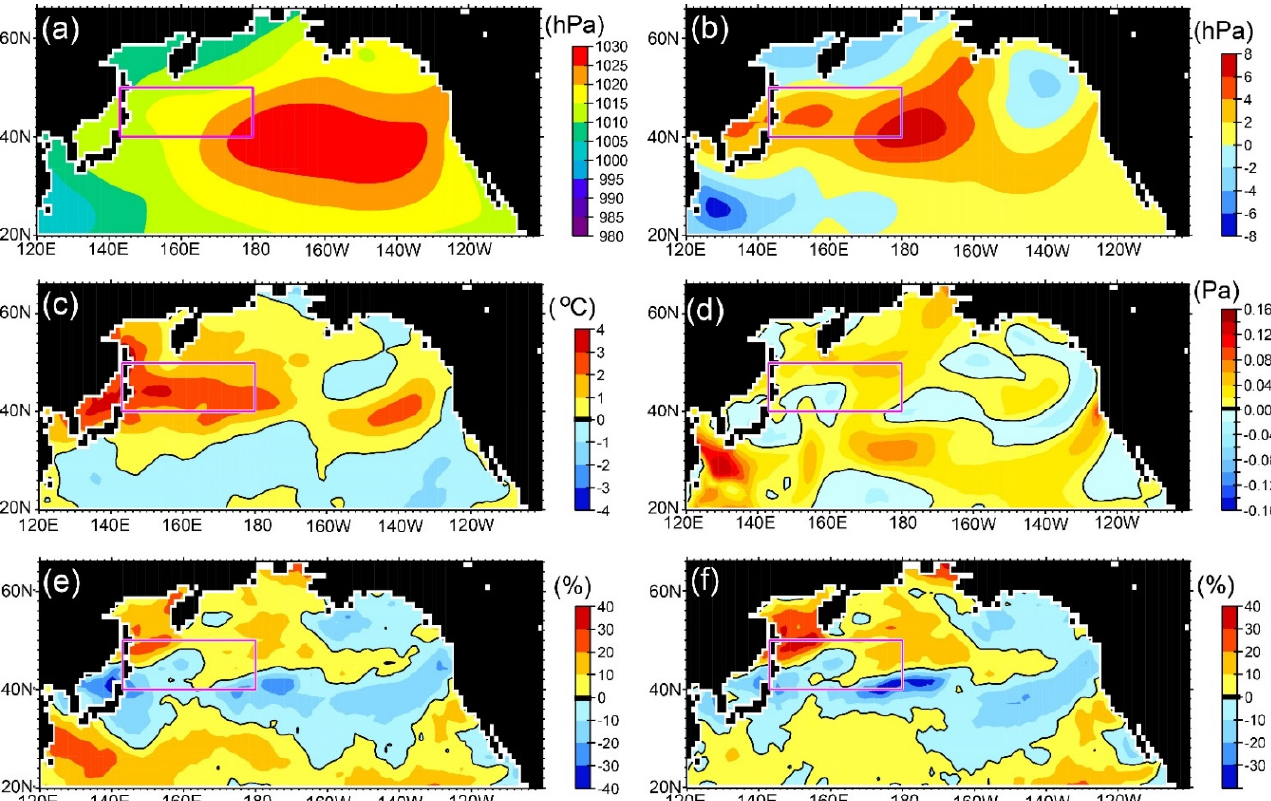
Figure 7. ( a ) Sea level pressure during 10–30 July 2021. Anomalies during 10–30 July 2021: ( b ) sea level pressure, ( c ) air temperature at 2 m above the sea surface, ( d ) magnitude of wind stress at 10 m above the sea surface, ( e ) total cloud cover, and ( f ) low cloud cover.